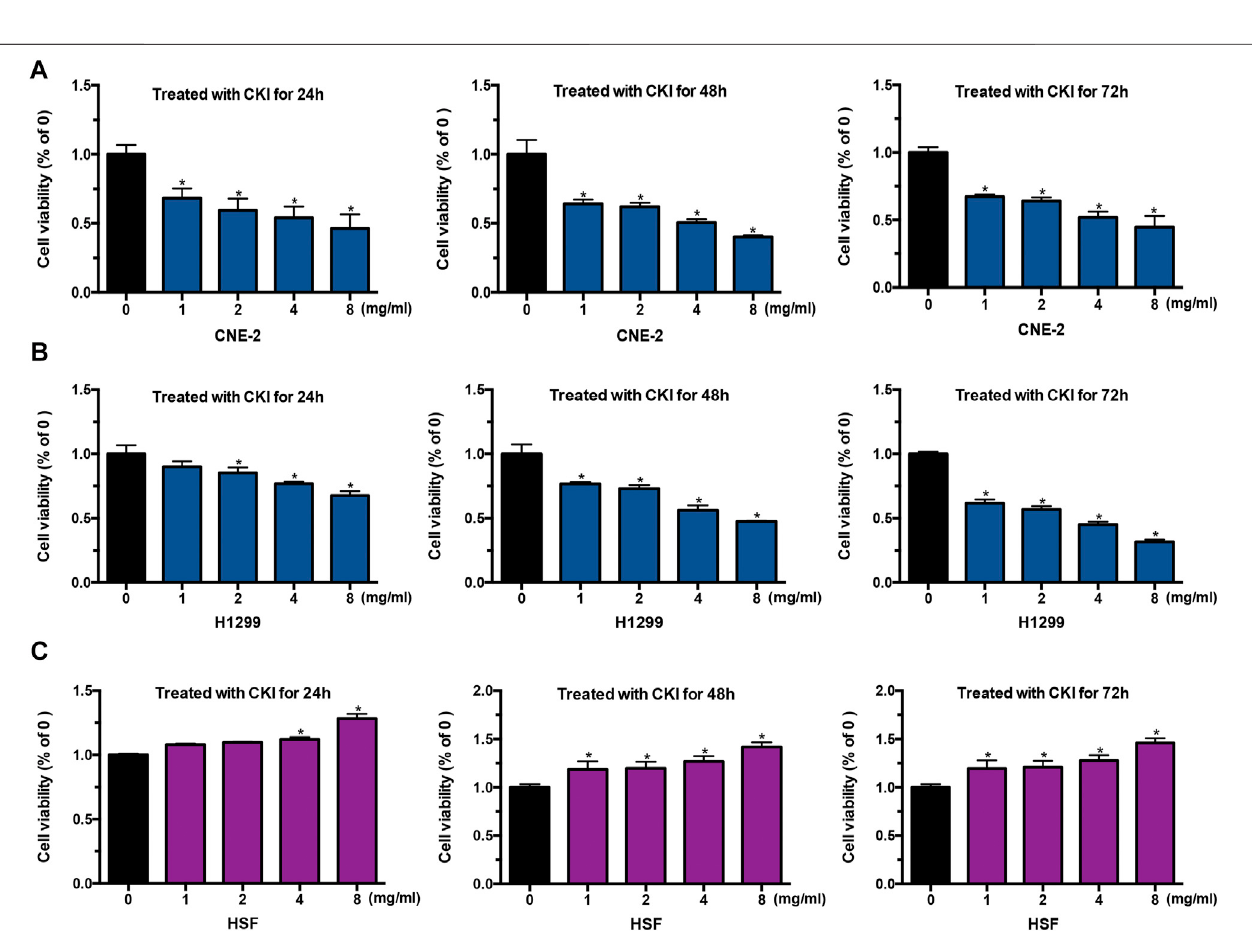
FIGURE 2 | CKI inhibited tumor cell growth while promotes HSF proliferation. (A – C) Cancer cells (CNE-2 and H1299) and HSF cells were treated with increased concentrationsofCKIfor24,48,and 72 h.Afterwards,cellsweretreatedwithMTTasdetailed inMaterialsandMethods. Values inbar graphsweregivenasthemean ± SD from three independent experiments performed in triplicate. *Indicates signi fi cant difference as compared to the untreated control group (* p < 0.05).